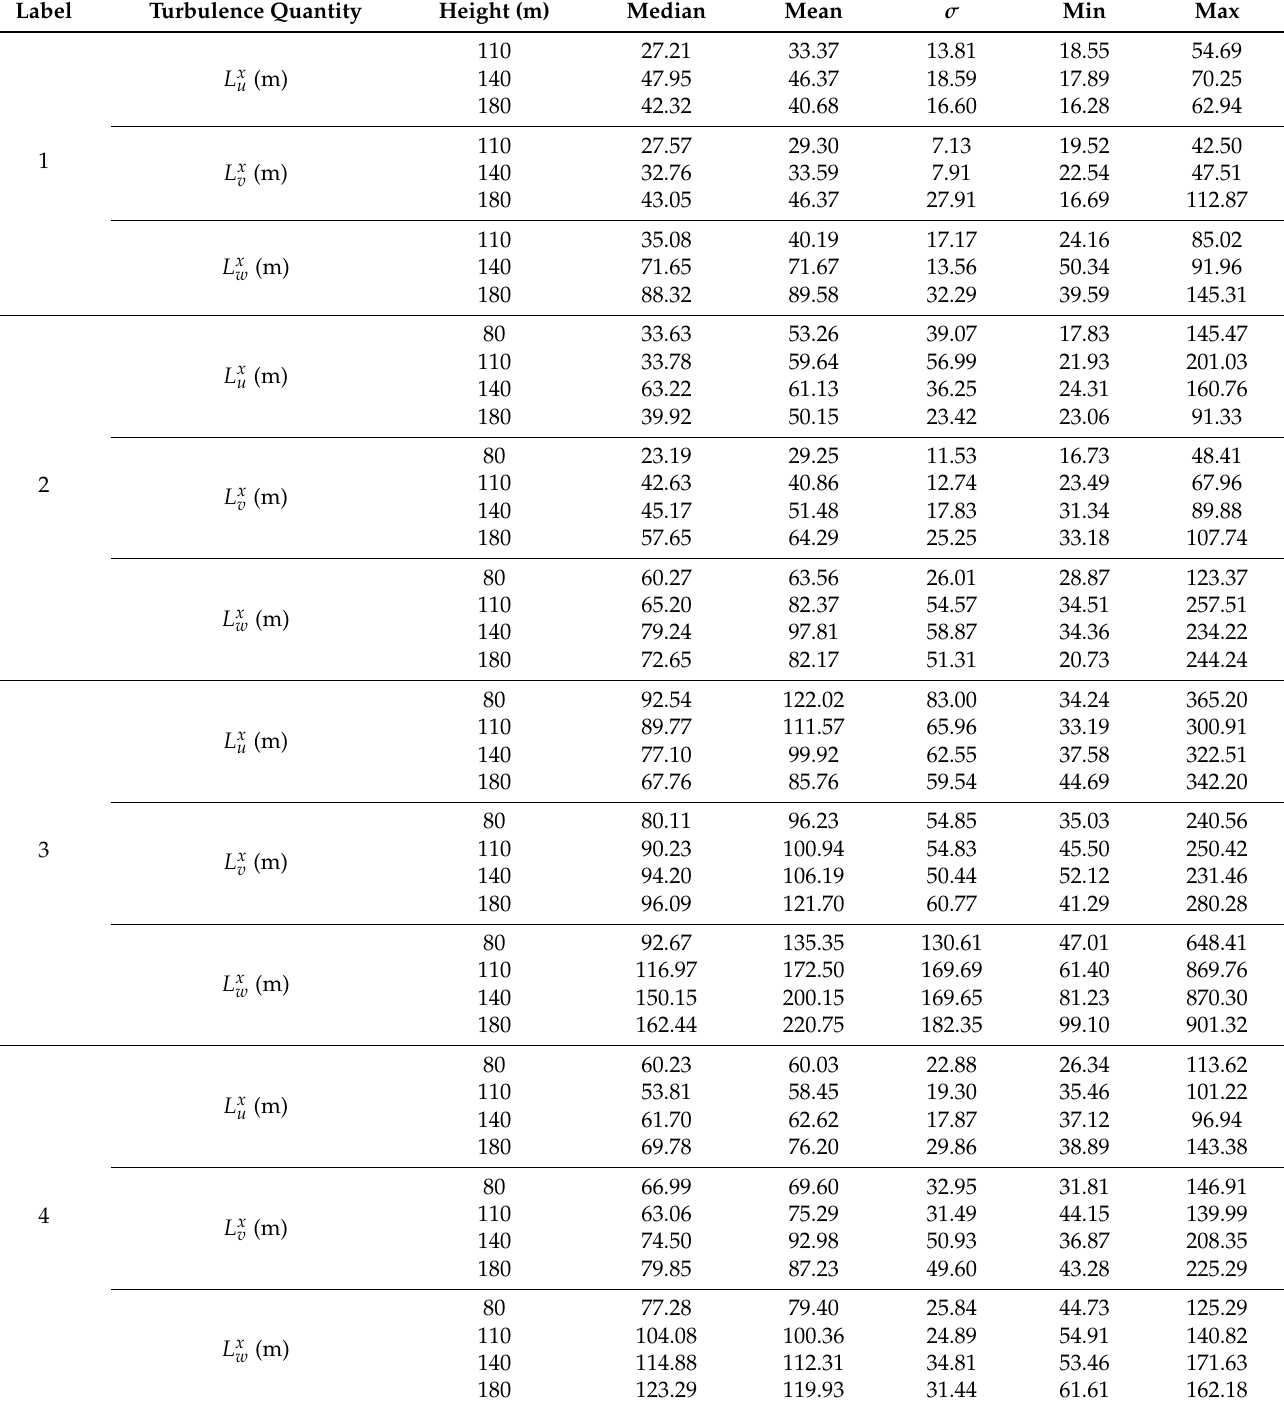
Table A2. Main characteristics of turbulence integral length scale in the along-wind direction, related to the velocity fluctuations in all three spatial directions: median, mean, standard deviation ( σ ), minimum and maximum values at four different heights are given for eight wind